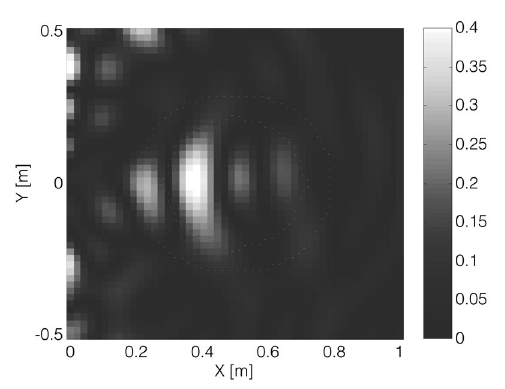
Fig. 11. Case 3: a buried empty pipe. Modulus of the real part of the reconstructed contrast when consid- ering noise-corrupted data (SNR=10